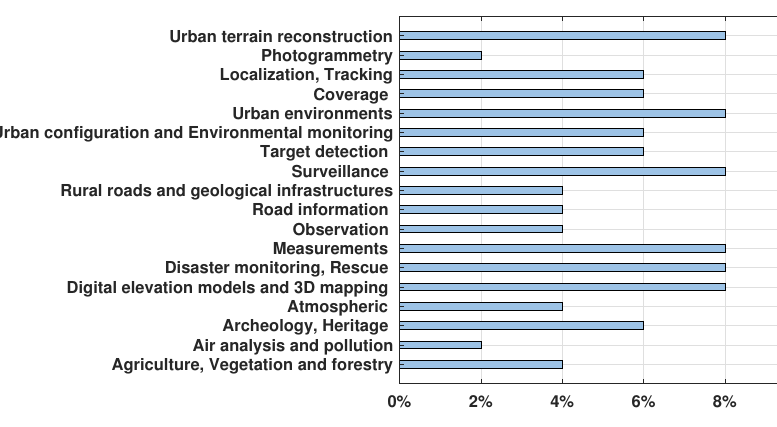
Figure 8. Percentage of aerial image applications.